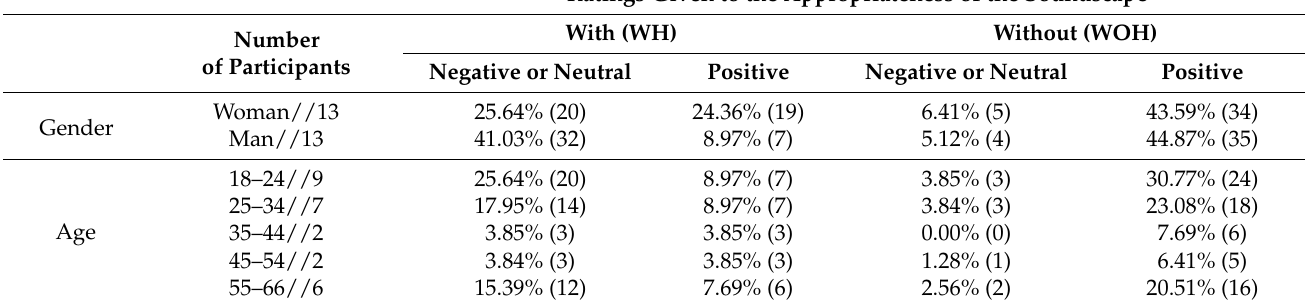
Table 1. Age and gender of the participants, split into the percentage of people who gave negative or neutral and positive ratings to the appropriateness of the soundscape for the three locations with (WH) and without the helicopter noise (WOH). The number of responses is given in parentheses. As there were 3 locations, responses are the number of participants multiplied by three for both the scenarios with and without helicopter noise. In addition, 100% refers to the total number of responses. Ratings Given to the Appropriateness of the